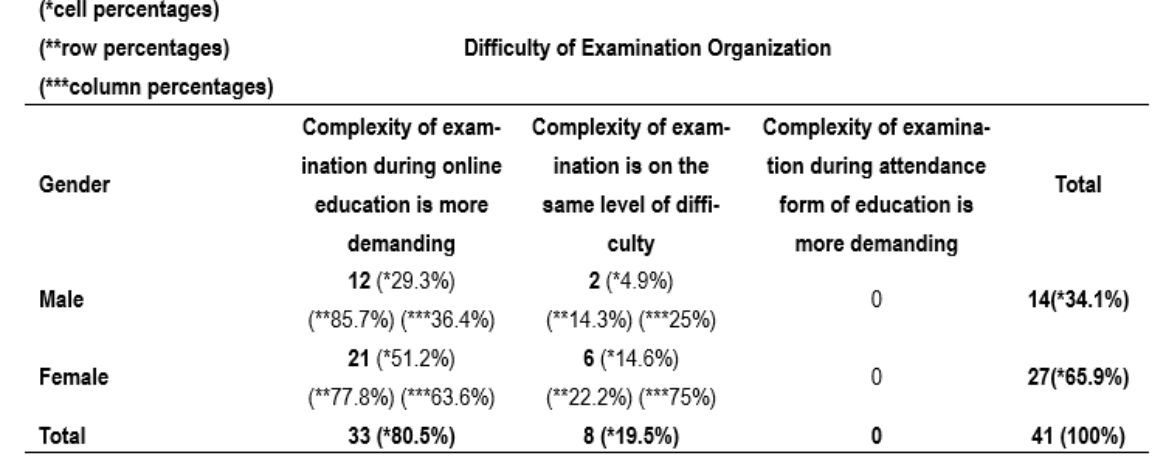
Difficulty of preparation for examination process depending on gender